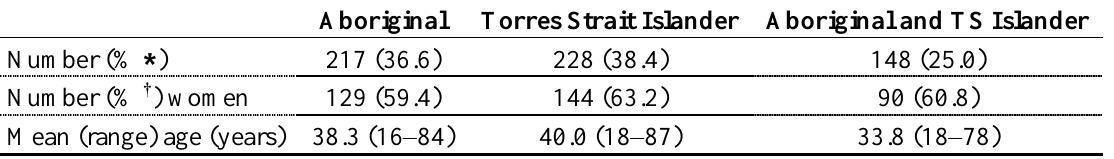
Table 1. Demographic characteristics of study participants (n =